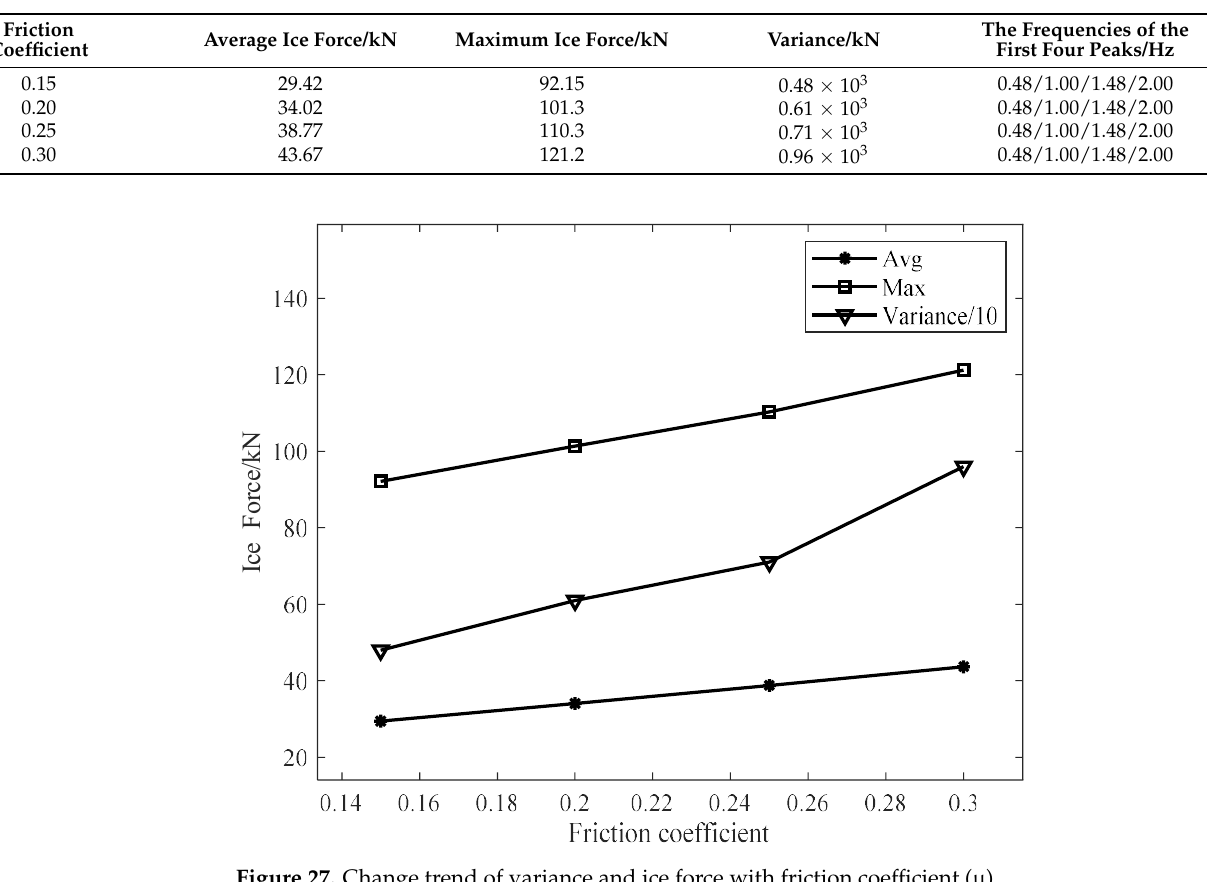
Figure 28. Time history curves of total ice force under different Young’s modulus ( E i ).